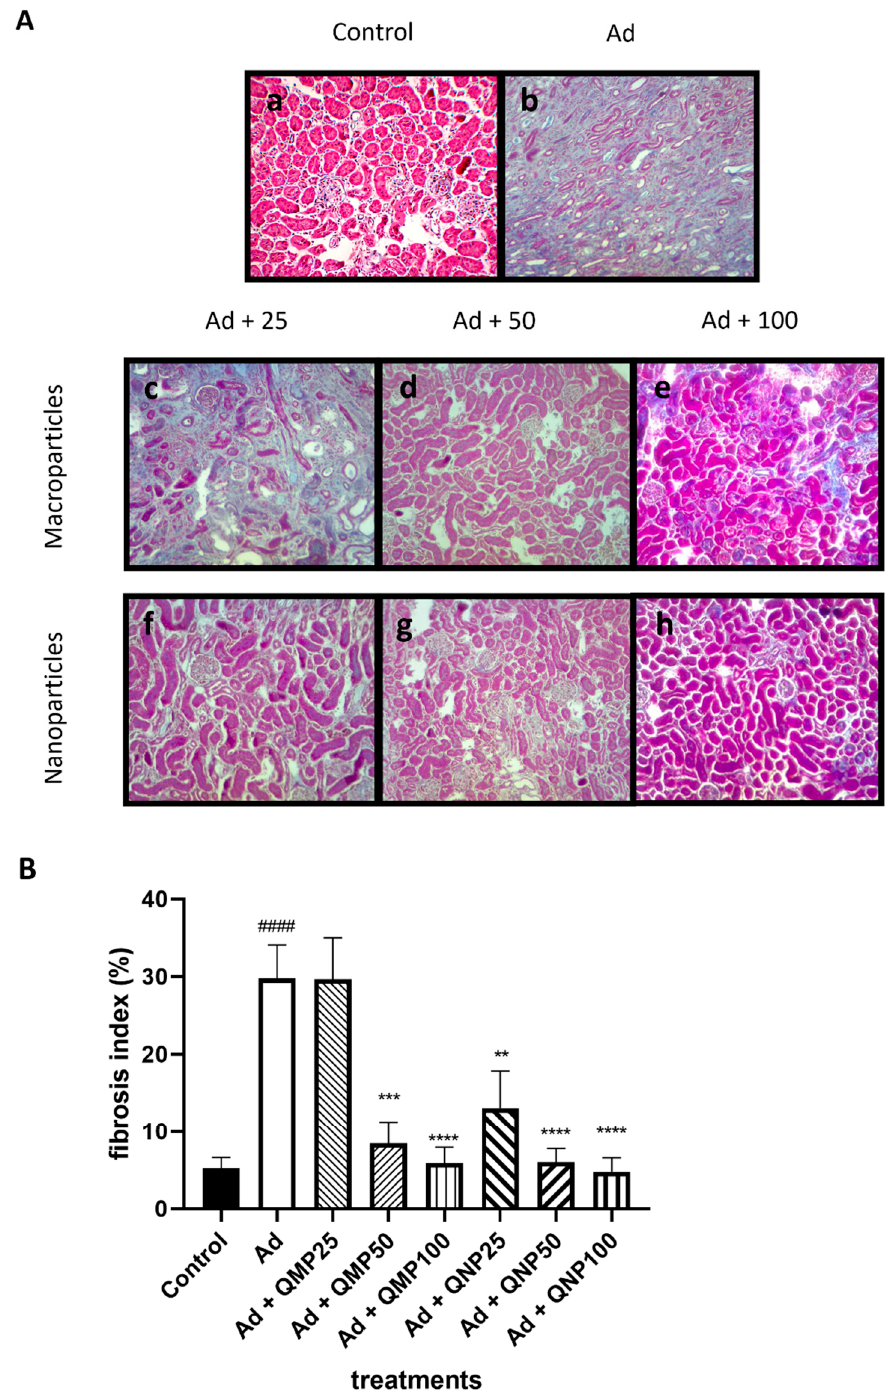
Figure 6. Fibrosis index analysis of kidney tissue. Fibrosis index analysis of kidney tissue was determined by Masson’s trichrome staining. ( A ) Treatment with quercetin diminished the extracellular deposition where QMPs ( c – e ) were not as effective as QNPs ( f – h ). ( B ) Quercetin diminished the fibrosis index in a dose-dependent manner, showing better results with QNPs than with QMPs. ( a ): Control, ( b ): Ad, ( c ): Ad + QMP25, ( d ): Ad + QMP50, ( e ): Ad + QMP100, ( f ): Ad + QNP25, ( g ): Ad + QNP50, ( h ): Ad + QNP100. Mean ± SD ( n = 5); #### p < 0.0001 compared to the Control group; ** p < 0.01, *** p < 0.001, **** p < 0.0001 compared to the Ad group. Magnification of 200 ×.